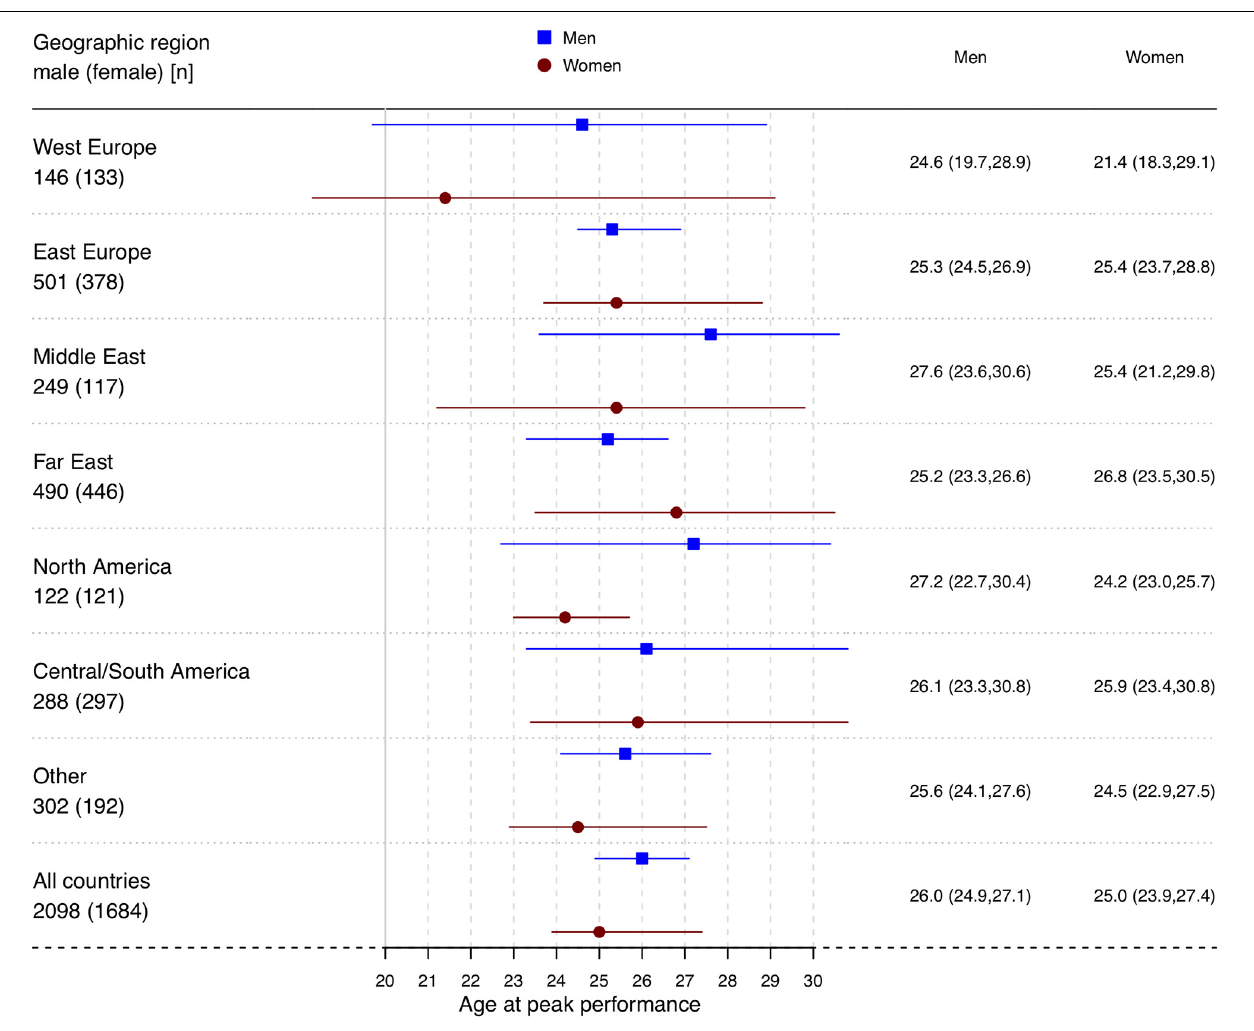
FIGURE 2 | Age at peak performance for 90th percentile performances in different geographical regions. Quantile regression with 95% bootstrap confidence